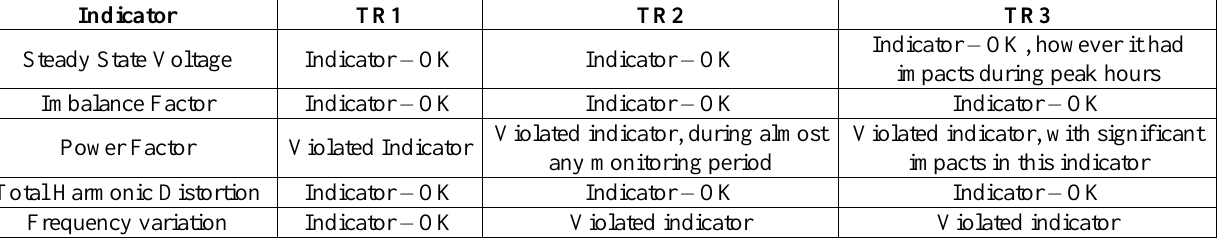
Table 2: Summary results of PQ